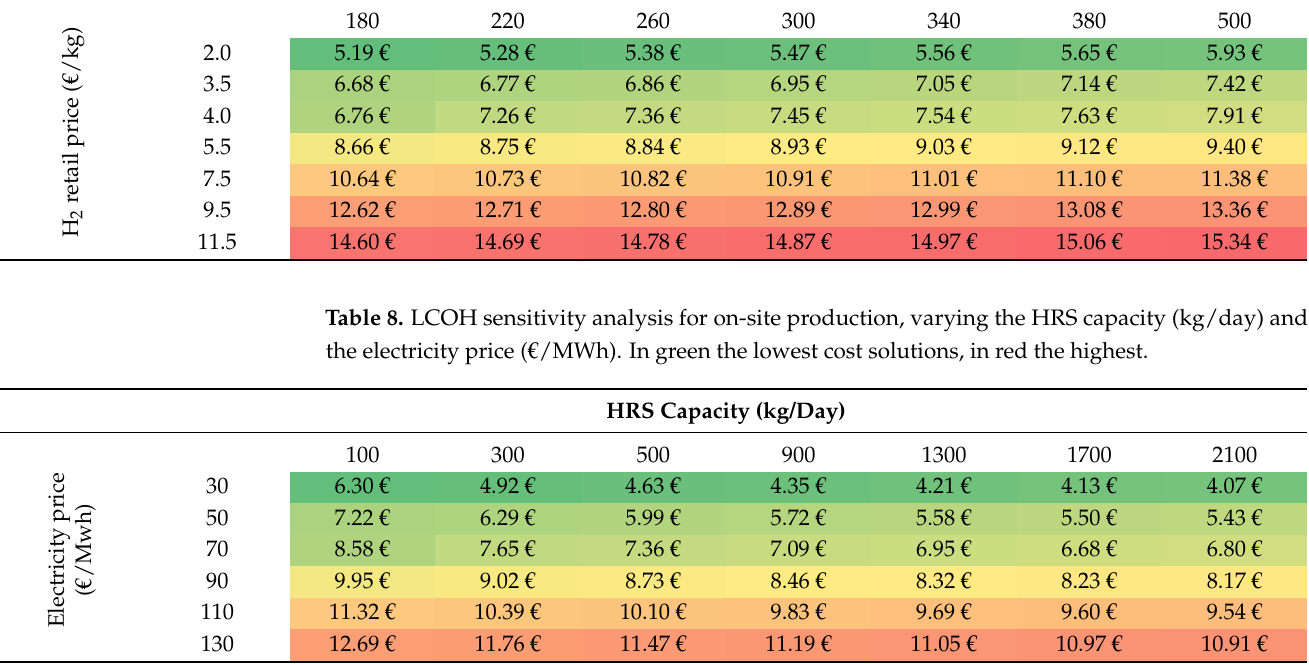
Table 7. LCOH sensitivity analysis for blue hydrogen delivery, varying the travel distance (km) and the H 2 retail price ( € /kg). In green the lowest cost solutions, in red the highest. Delivery Distance (km)